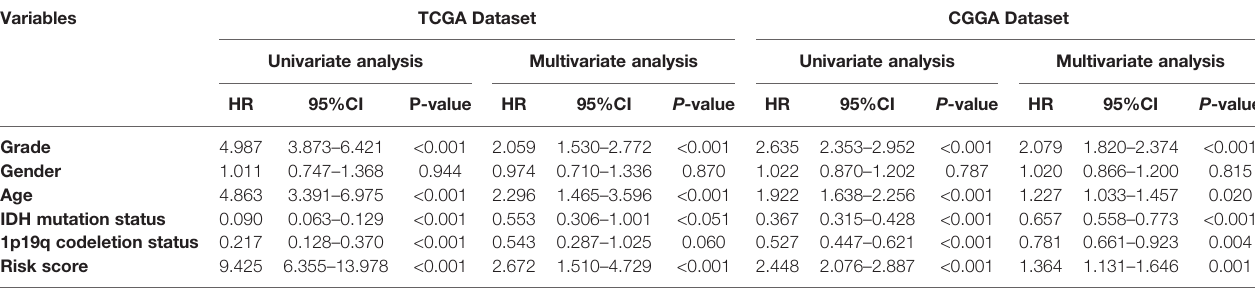
TABLE 1 | Univariate and multivariate Cox regression analyses of clinicopathologic characteristics associated with overall survival in TCGA dataset and CGGA dataset.